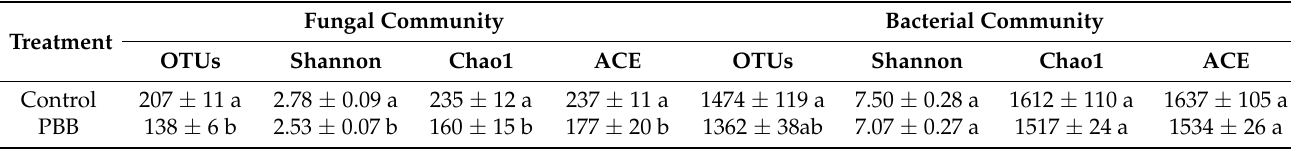
Table 4. Operational taxonomic unit (OTU) richness and diversity indices of PBB